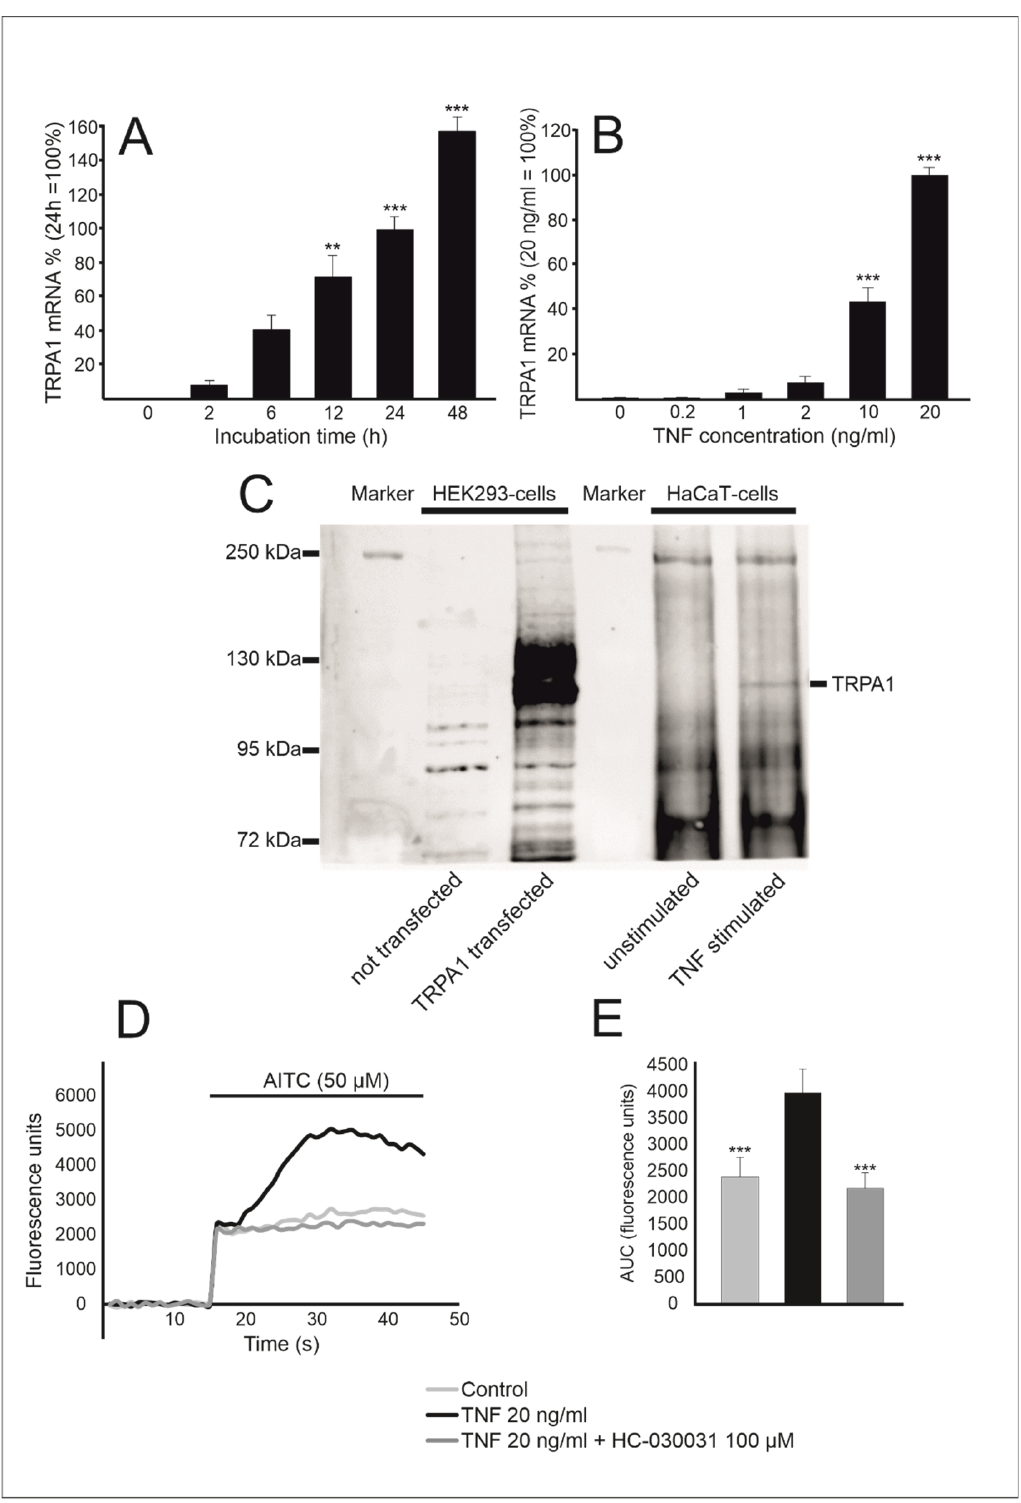
Figure 1. Tumor necrosis factor (TNF) induces transient receptor potential ankyrin 1 ( TRPA1 ) expression in human HaCaT keratinocytes in a time and dose-dependent manner. HaCaT cells were stimulated with TNF (20 ng/mL) for indicated times ( A ) or with an increasing concentration of TNF (from 0.2 ng/mL to 20 ng/mL) for 24 h ( B ). Thereafter total RNA was extracted and TRPA1 expression was measured by RT-PCR. Results were normalized against GAPDH mRNA. TRPA1 mRNA level at 24 h ( A ) and with 20 ng/mL ( B ) was set as 100% and the other values are given in relation to that value. Results are expressed as mean + SEM, n = 4. Statistical significance was calculated against 2 h ( A ) or control without added TNF ( B ) using one-way ANOVA with Bonferroni’s post-test. ** = p < 0.01, *** = p < 0.001. In ( C ), HaCaT keratinocytes were cultured with TNF (20 ng/mL) for 48 h. After protein extraction and immunoprecipitation, TRPA1 protein